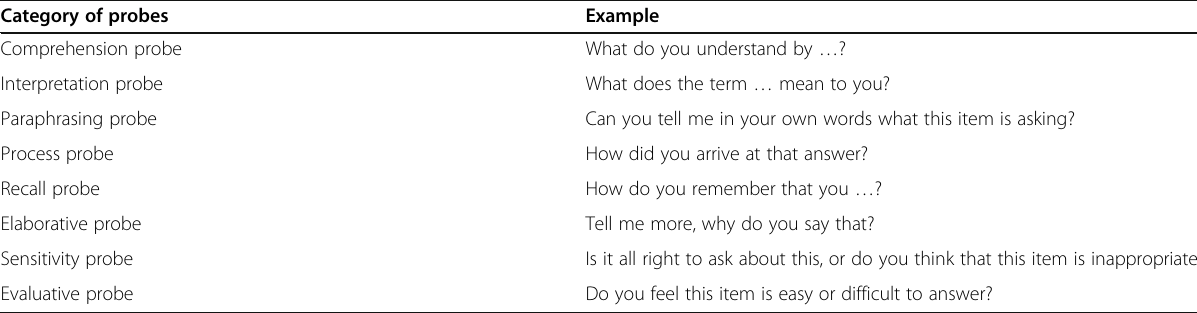
Table 3 Cognitive probes based on Tourangeau [34] and Willis [37]